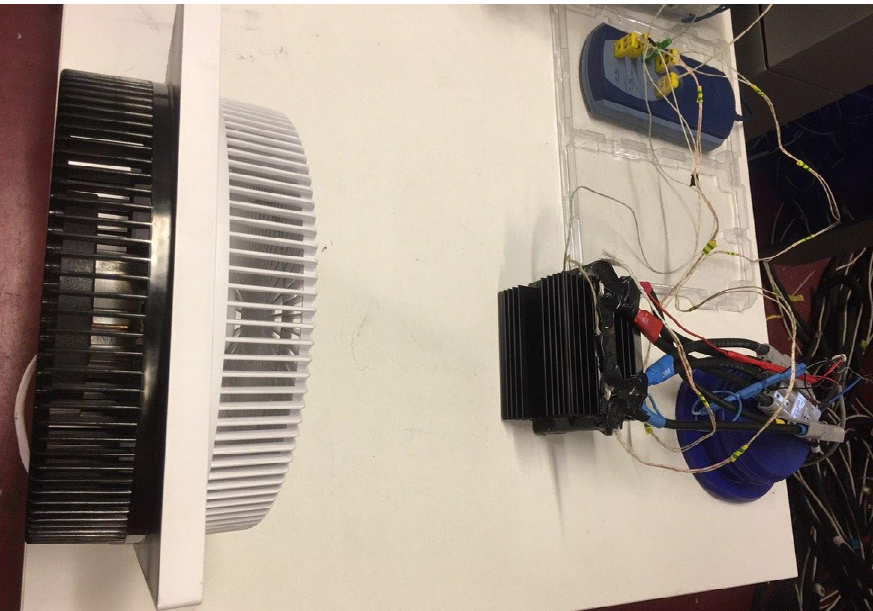
Figure 18. The experimental test setup of the hybrid TMS including an air-cooling system and a large extruded heat sink [90].